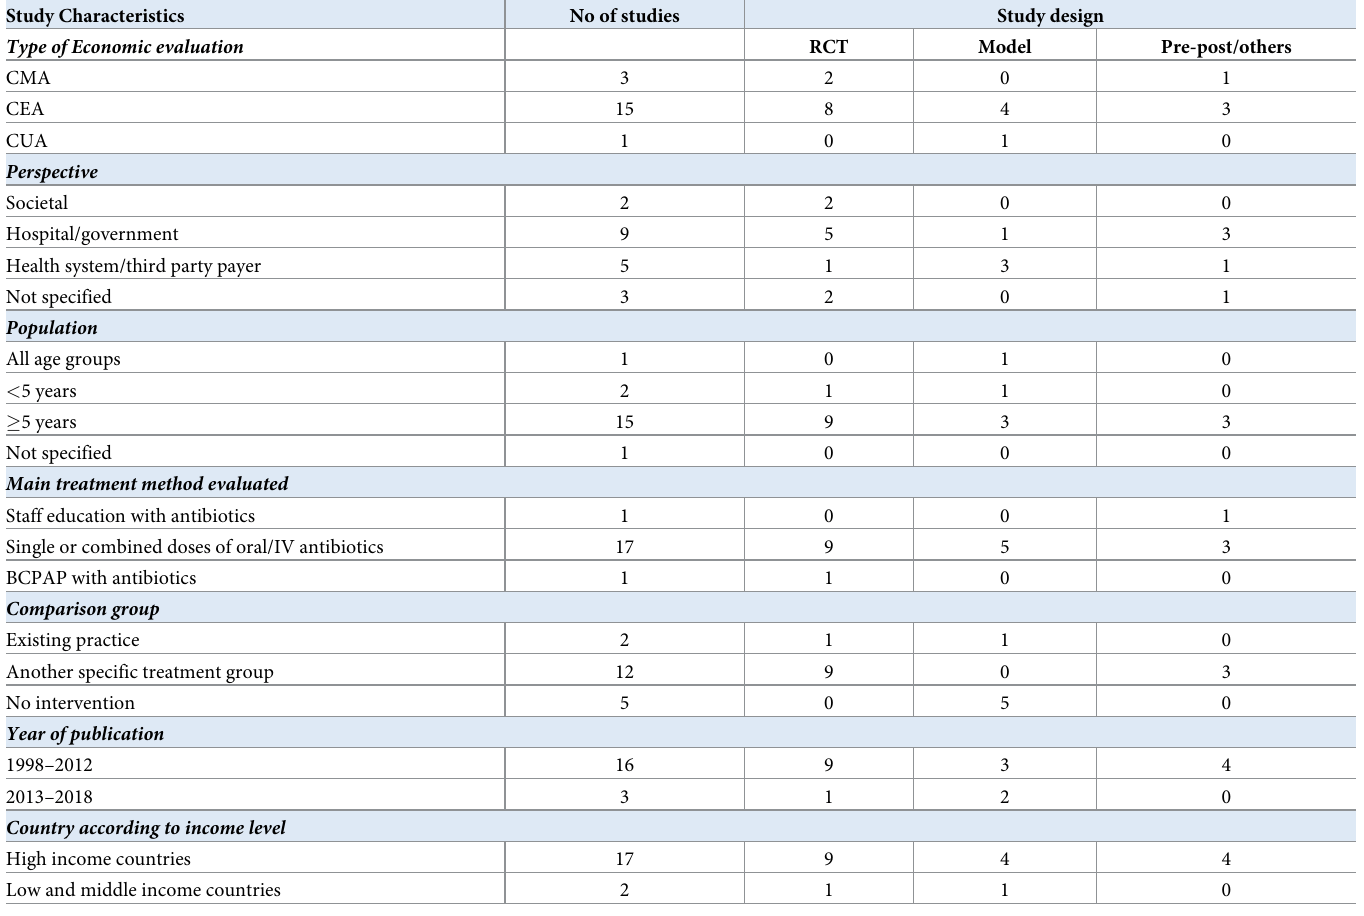
Table 1. Summary of study